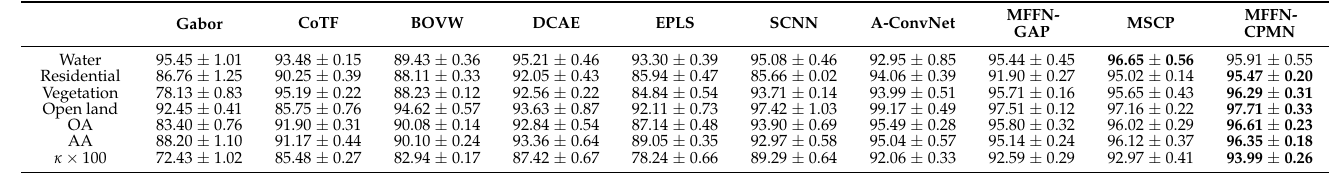
Table 8. Classification performance of F-SAR image with different